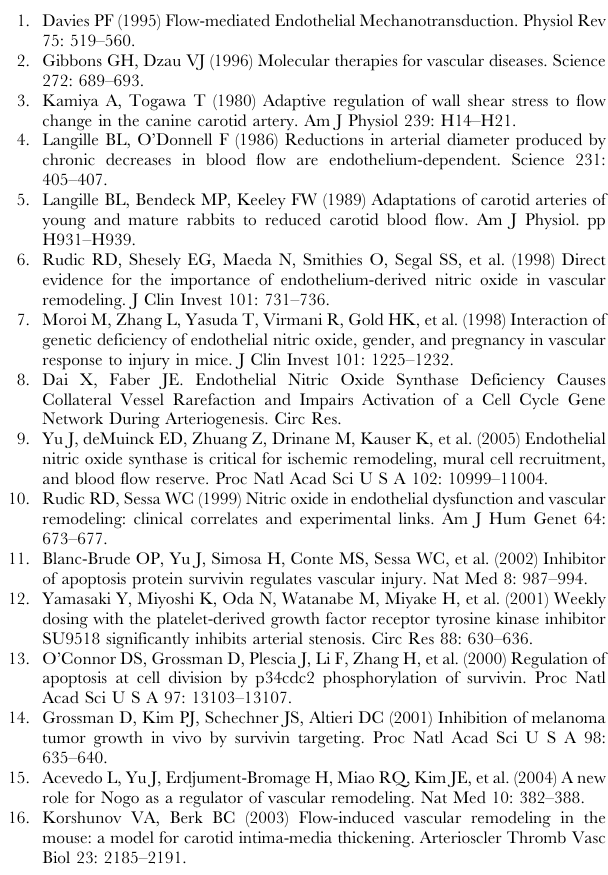
Figure S1 Growth factor and receptor expression in ligated LC in C57Bl/6J and eNOS ( 2 / 2 ) mice. Quanti- tative RT-PCR was performed using single remodeled LC and contralateral RC from C57BL/6J and eNOS ( 2 / 2 ) mice. There was no change of mRNA level of multiple growth factors and their